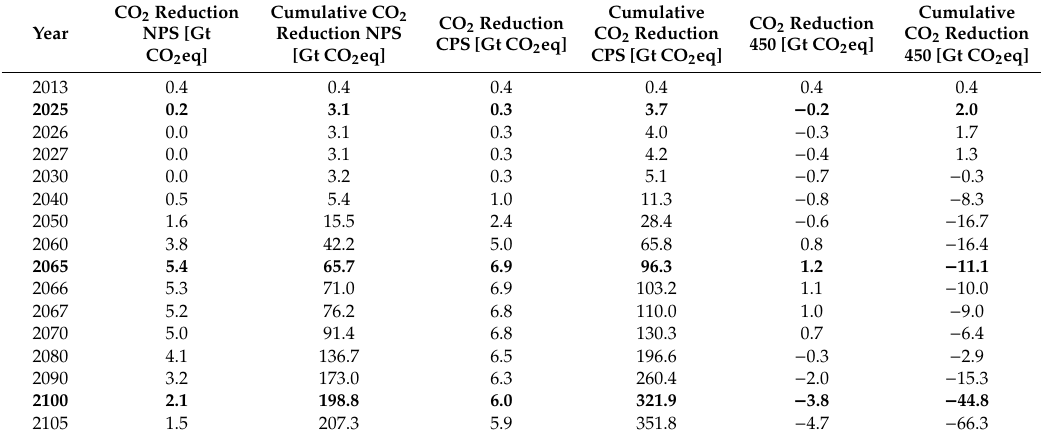
Table 6. Possible CO 2 emission reduction for scenario S1, sub scenario A.